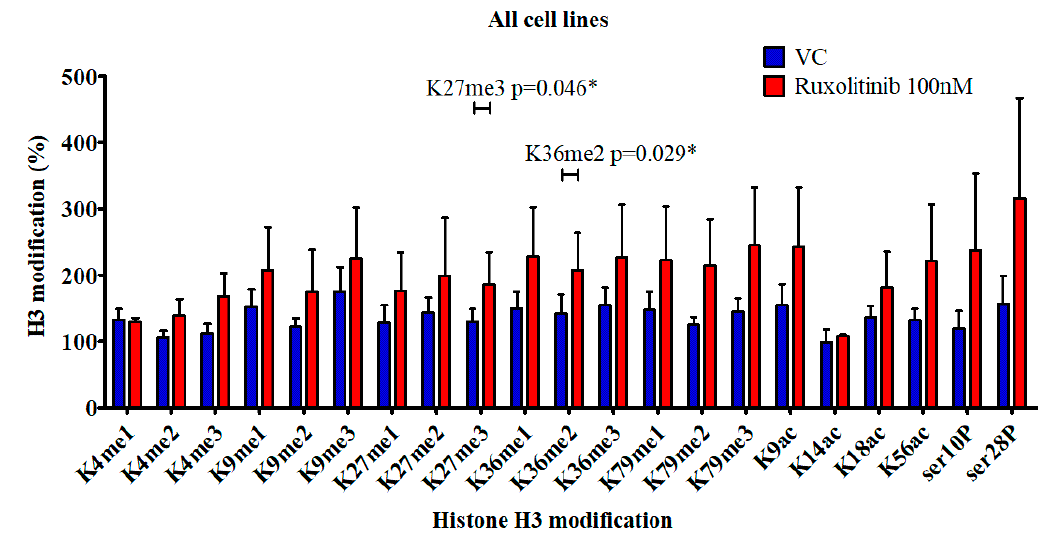
Figure 1. H3 modification as a percentage of total H3 present in myeloproliferative neoplasm (MPN) cell lines. * p value < 0.05.